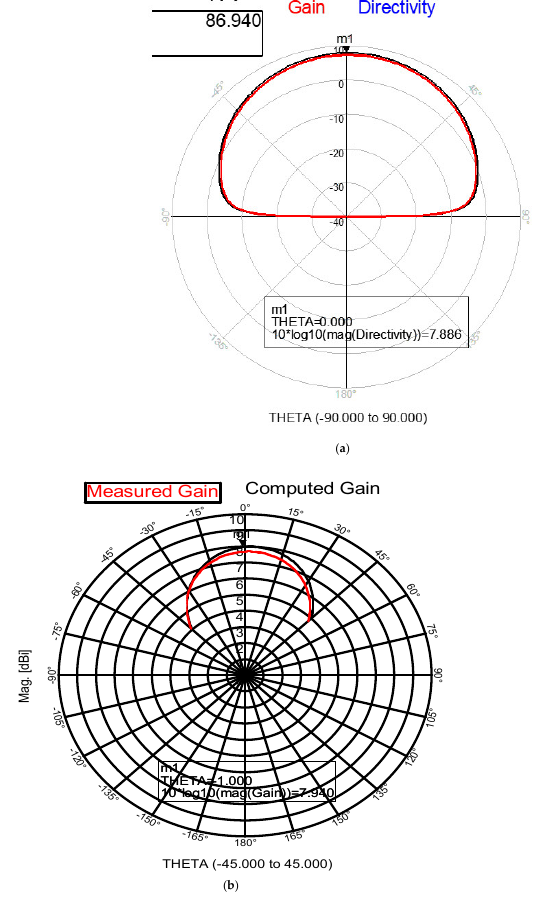
Table 3. Branch line coupler design. Impedance